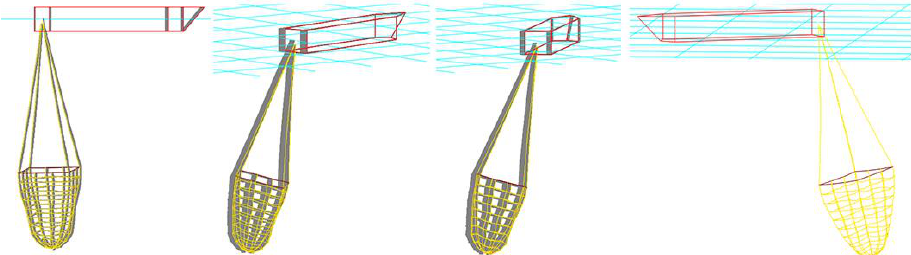
Figure 25. The time domain image of the cables ’ tension of the rigid truss trawl system in rotating Figure 26. Shape changes of rigid truss trawl in rotating towing under fixed angular velocity at v = towing under fixed angular velocity: ( a ) Line Lower; ( b ) Line Upper; ( c ) Line Port; ( d ) Line Stbd. 1 m/s.